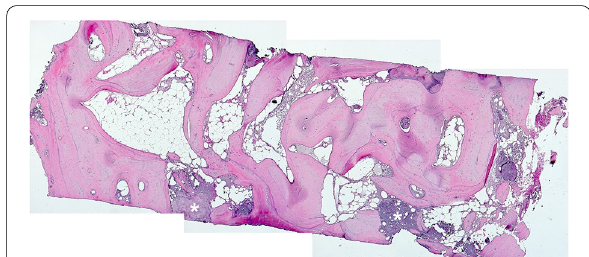
Fig. 8 Overview after reconstruction of single sections, newly formed cancellous bone, white asterisks detritus, HE staining, = original magnification ×